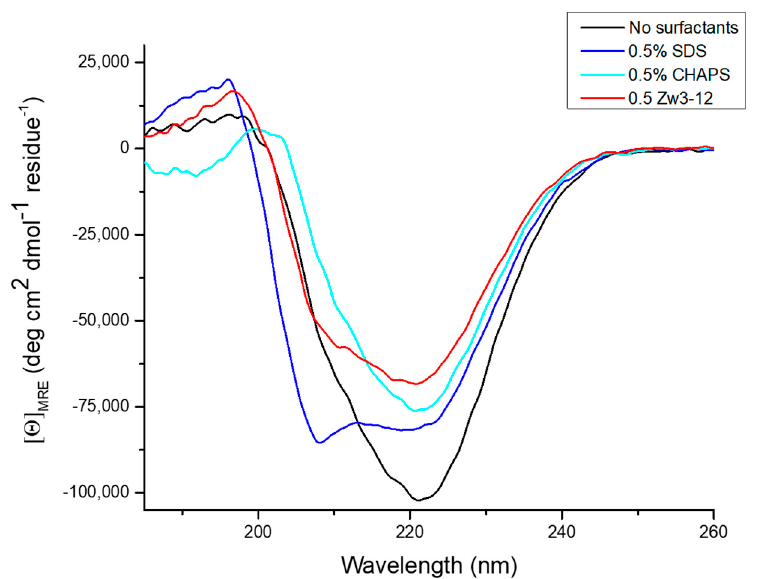
Figure 6. Mean residue ellipticity [ θ ] MRE as a function of the wavelength of the far UV CD spectra of 10 µM OVA (black line) and 10 µM OVA in the presence of 0.5 wt% surfactants at 25 °C. All samples were buffered at pH 7.4 with a 10 mM sodium phosphate buffer.